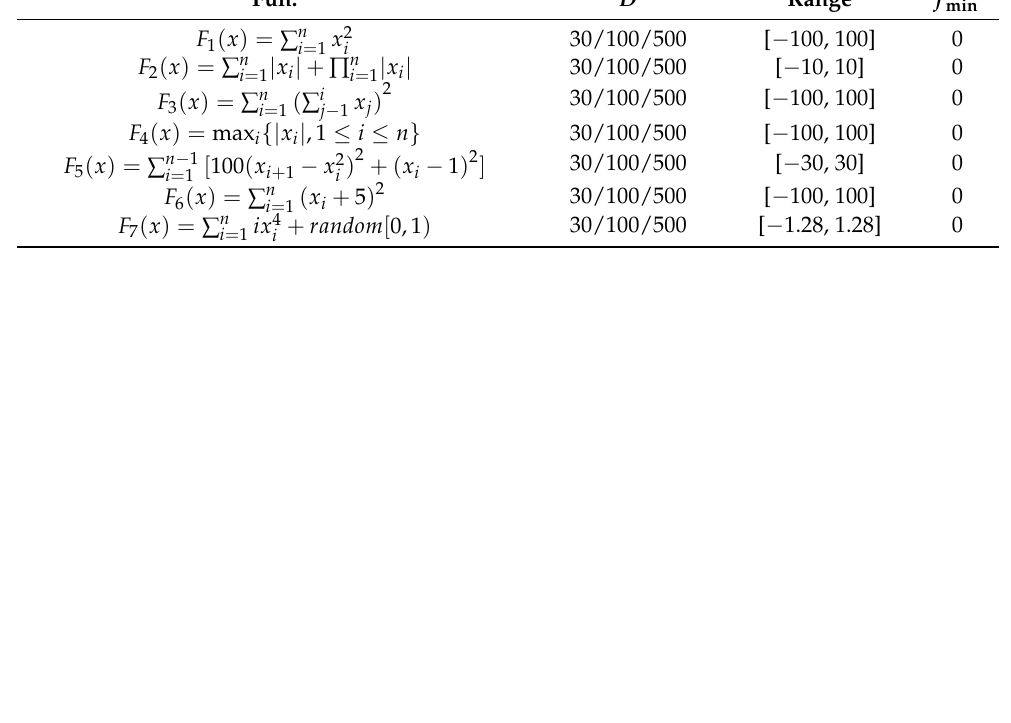
Table 2. Unimodal benchmark functions. Fun.